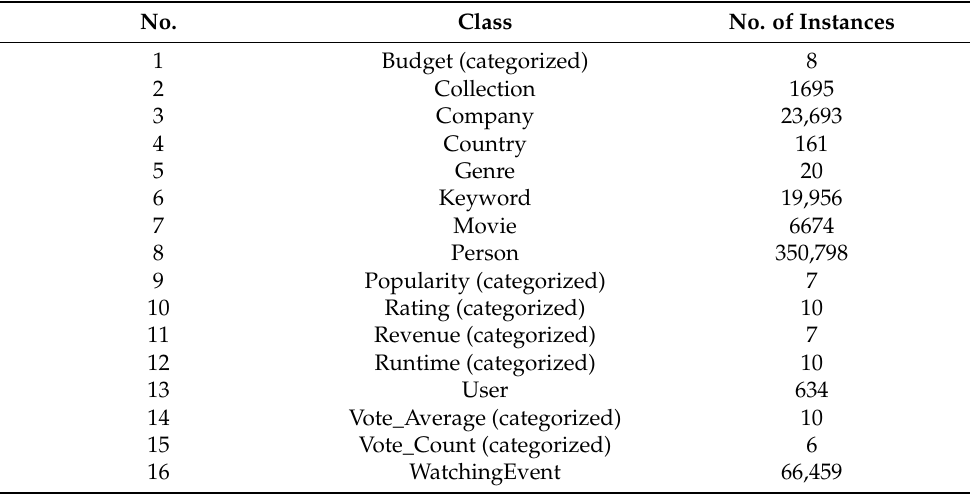
Table 6. The number of instances by class used in the experiment.